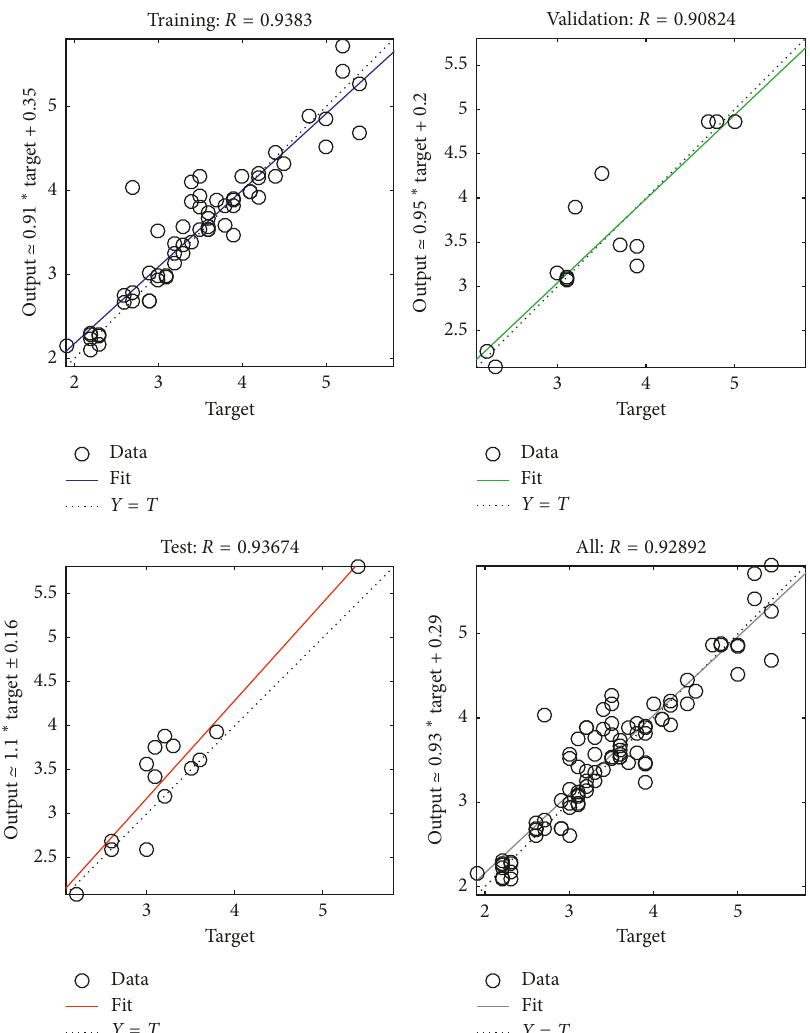
Figure 10: Training, validation, testing phases, and all data for the Marshall flow (mm) ANN